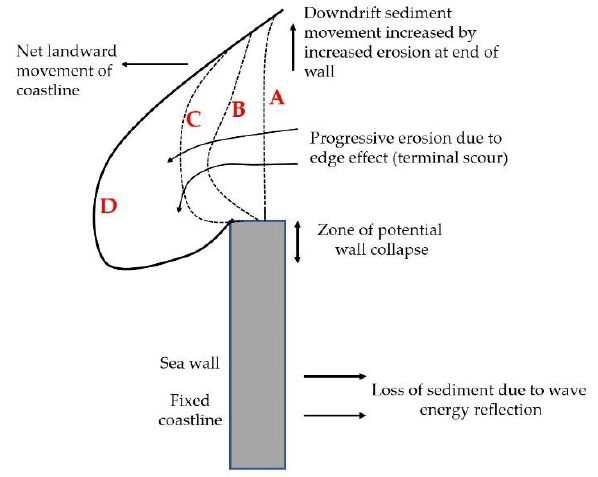
Figure 1. An explanatory diagram and overview of the end effect occurrence [1].